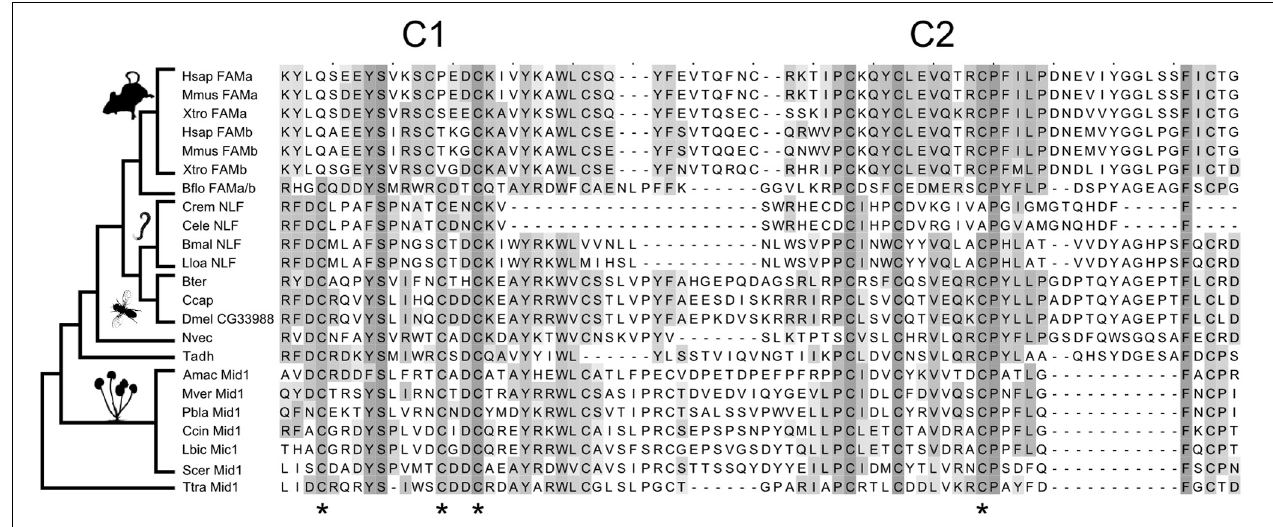
FIGURE 1 | Evolution of the Mid1 superfamily. Key cysteine residues are conserved between fungal and animal Mid1. Stars are placed under four cysteine residues that are necessary for Mid1 function in yeast (Maruoka et al., 2002). Three of the four are conserved in fungi, vertebrates and Caenorhabditis , and all four are conserved in all other sampled animals. The sampling of the key outgroups to vertebrates ( Branchiostoma floridae ) and Caenorhabditis ( Brugia malayi and Loa loa ) allows us to reconstruct the loss of key cysteines and confidently assign homology. The species sampled, from top to bottom are: Vertebrates: Hsap, Homo sapiens ; Mmus, Mus musculus ; Xtro, Xenopus tropicalis . Chordates: Bflo, Branchiostoma floridae